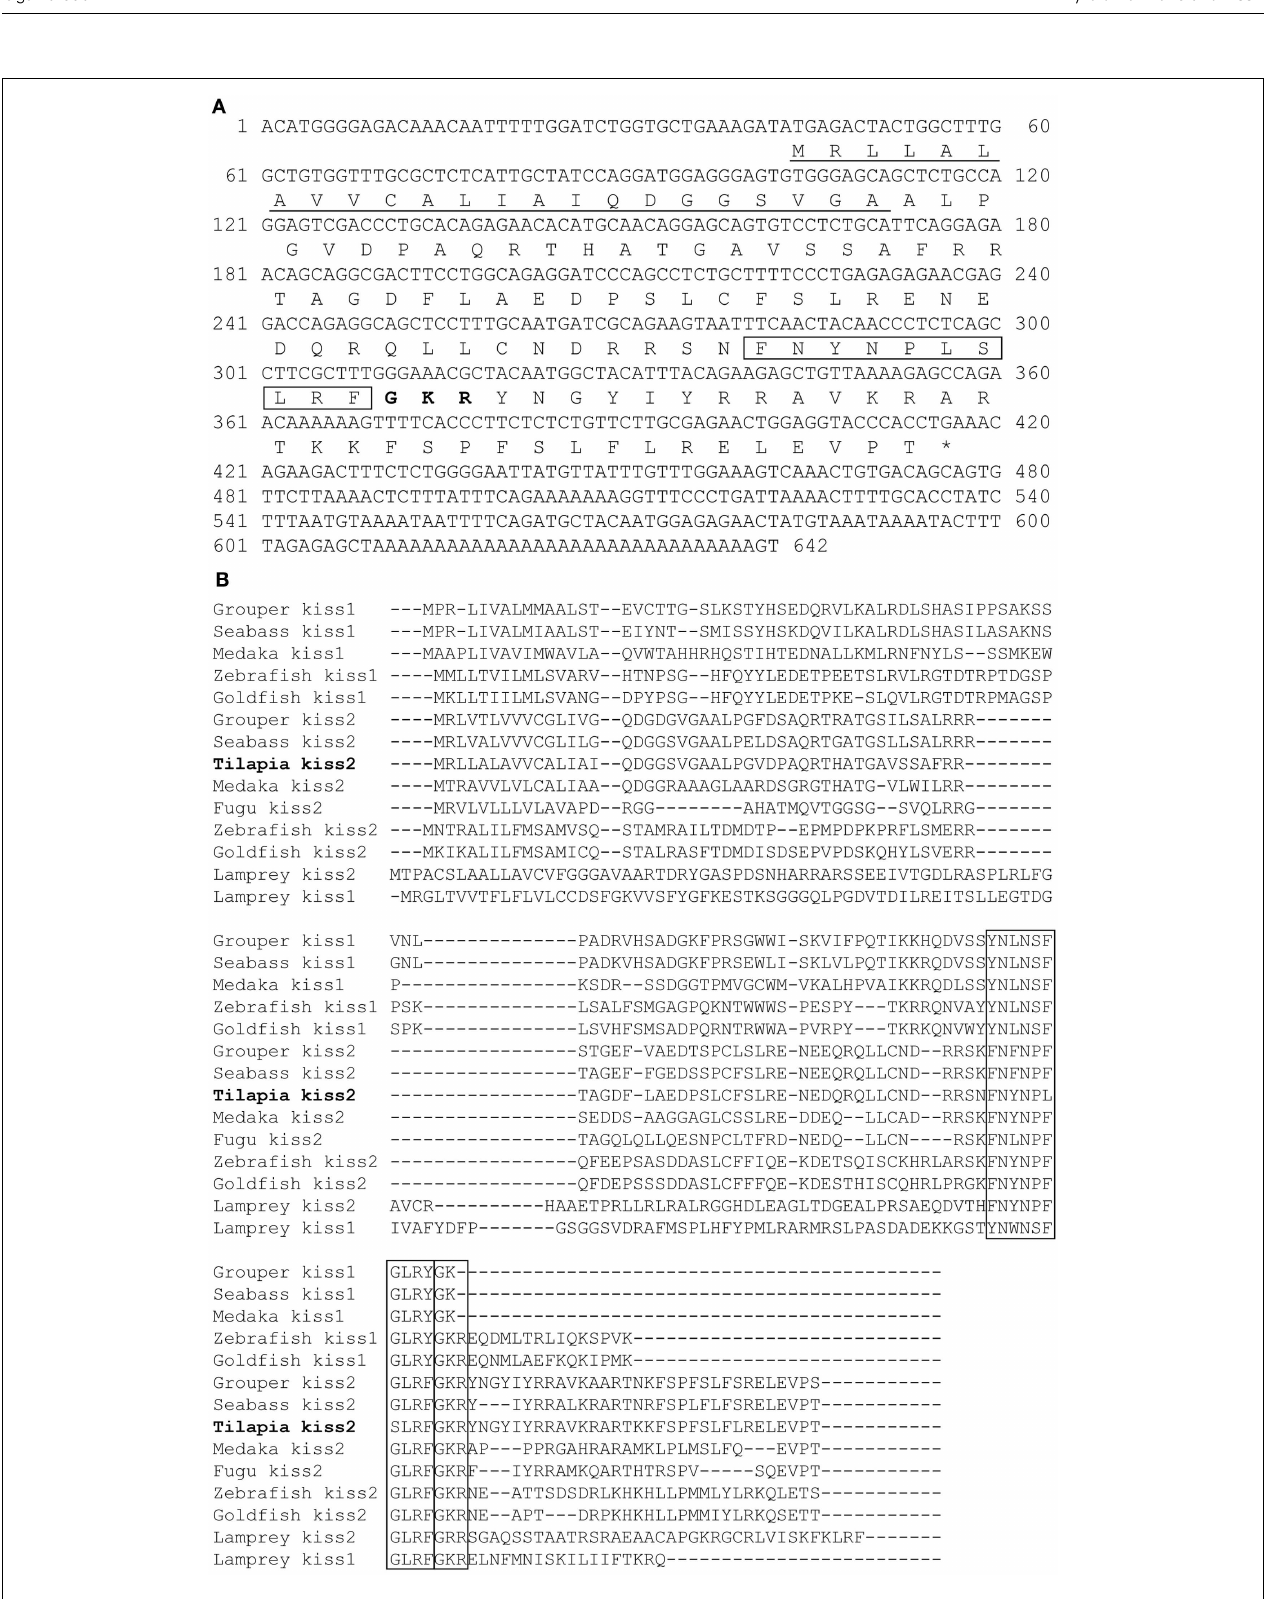
asterisk. (B) Comparison of amino acid sequences of kisspeptin precursors from different species.The mature peptides and potential cleavage amidation site (GKR/GK/GKK) are boxed. Sequences were aligned by the ClustalW program. Gaps (indicated by hyphens) are introduced in some sequences to maximize